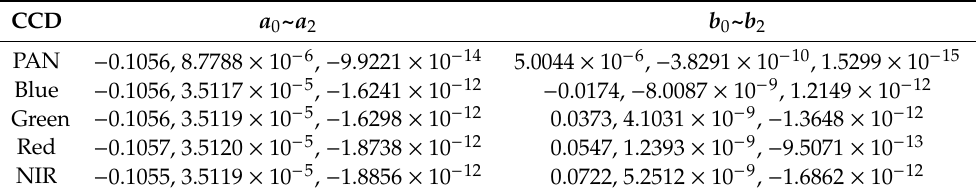
Table 2. Parameters of CCD line alignment.